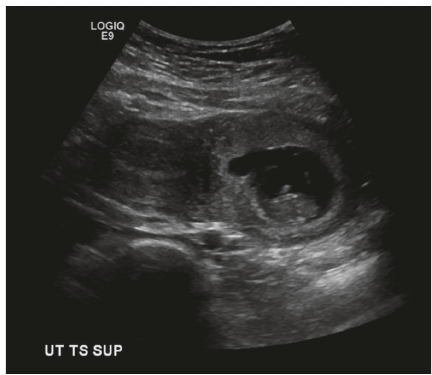
Figure 1: Bicornuate uterus at 9 + 5-week dating scan.